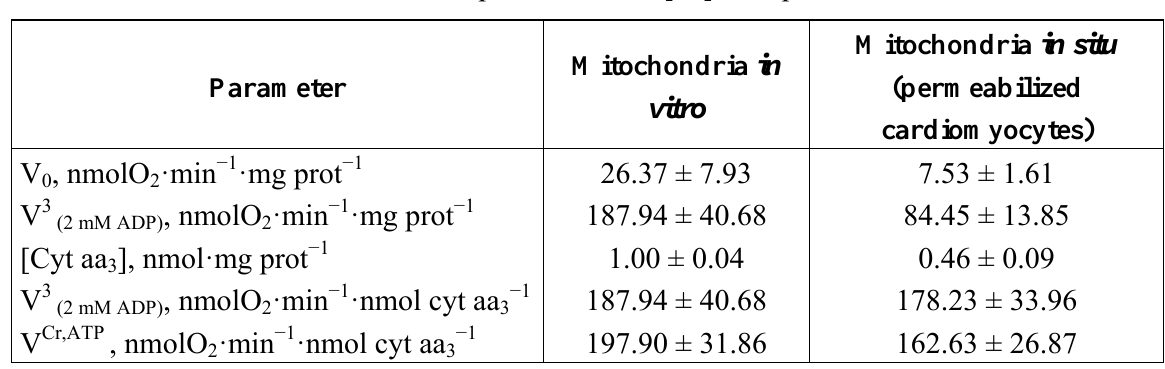
Table 1. Basic respiration parameters of isolated rat heart mitochondria and of mitochondria in situ in permeabilized cardiomyocytes.V 3 –respiration rate in the presence of 2 mM ADP, V Cr,ATP –respiration rate in the presence of activated MtCK by 2 mM ATP and 20 mM Creatine; Reproduced from [29] with